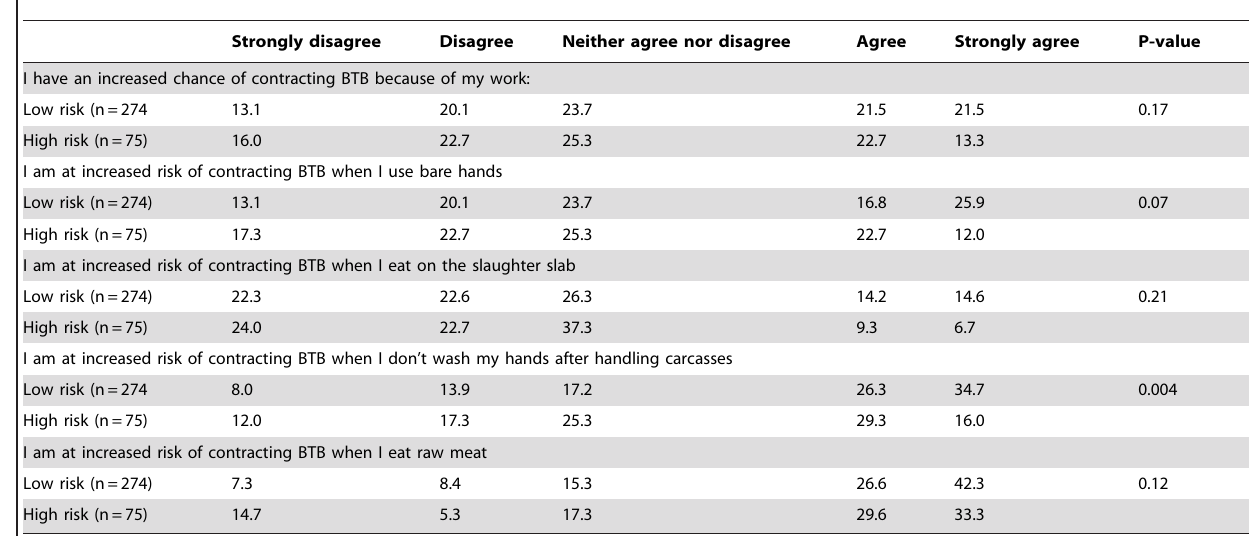
Table 4. Perceived susceptibility (values are